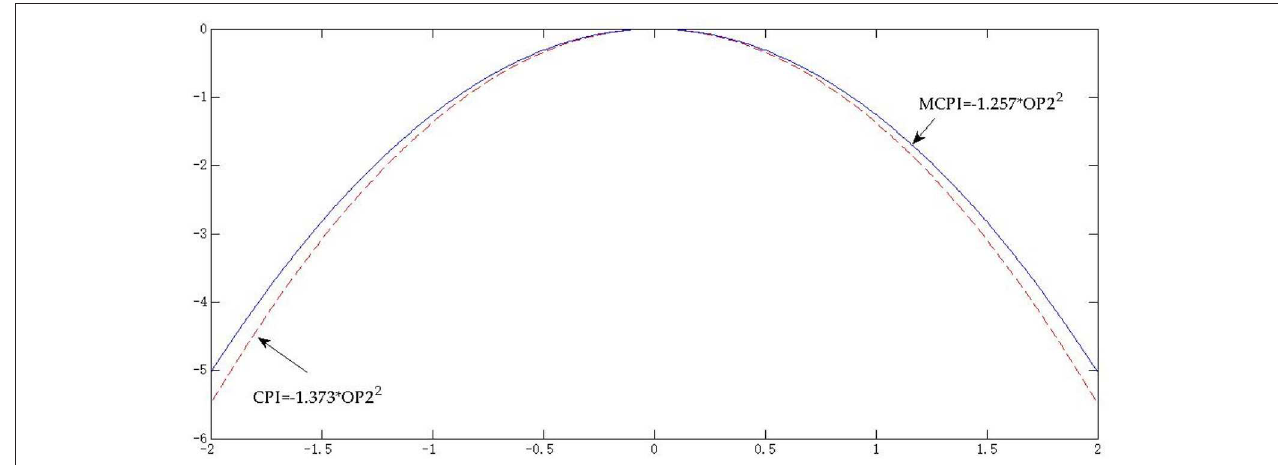
FIGURE 4 | Snapshot of the non-linear pass-through of the WTI oil price. For simplicity, we have omitted the other variables in Equation (6) and only report the non-linear term; thus, there is no effect of WTI oil price on consumer prices for both CPI and MCPI when they are located at the coordinates